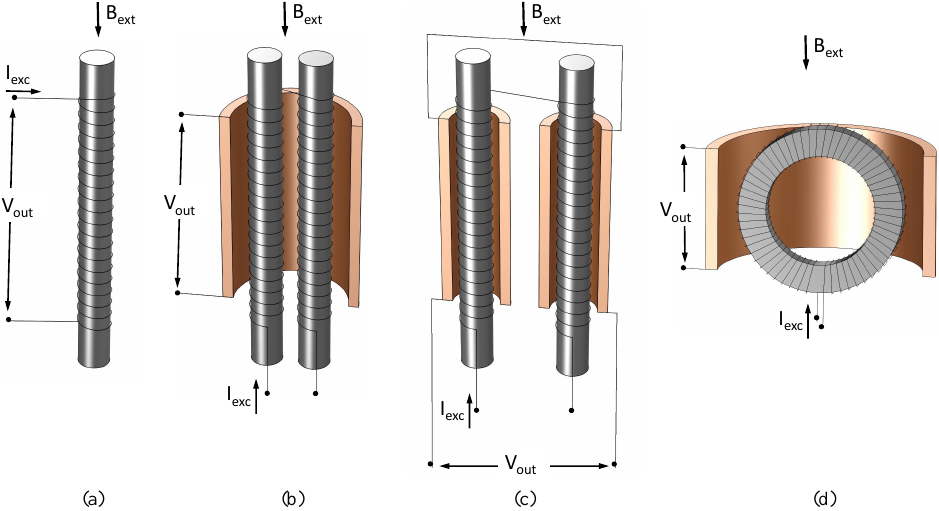
Figure 2. Parallel fluxgate configurations. ( a ) Single-core, ( b ) Vacquier, ( c ) F¨orster, ( d ) Aschenbrenner, and Goubau (ring-core); in gray is the ferromagnetic core and the detection winding is in orange when separate from the